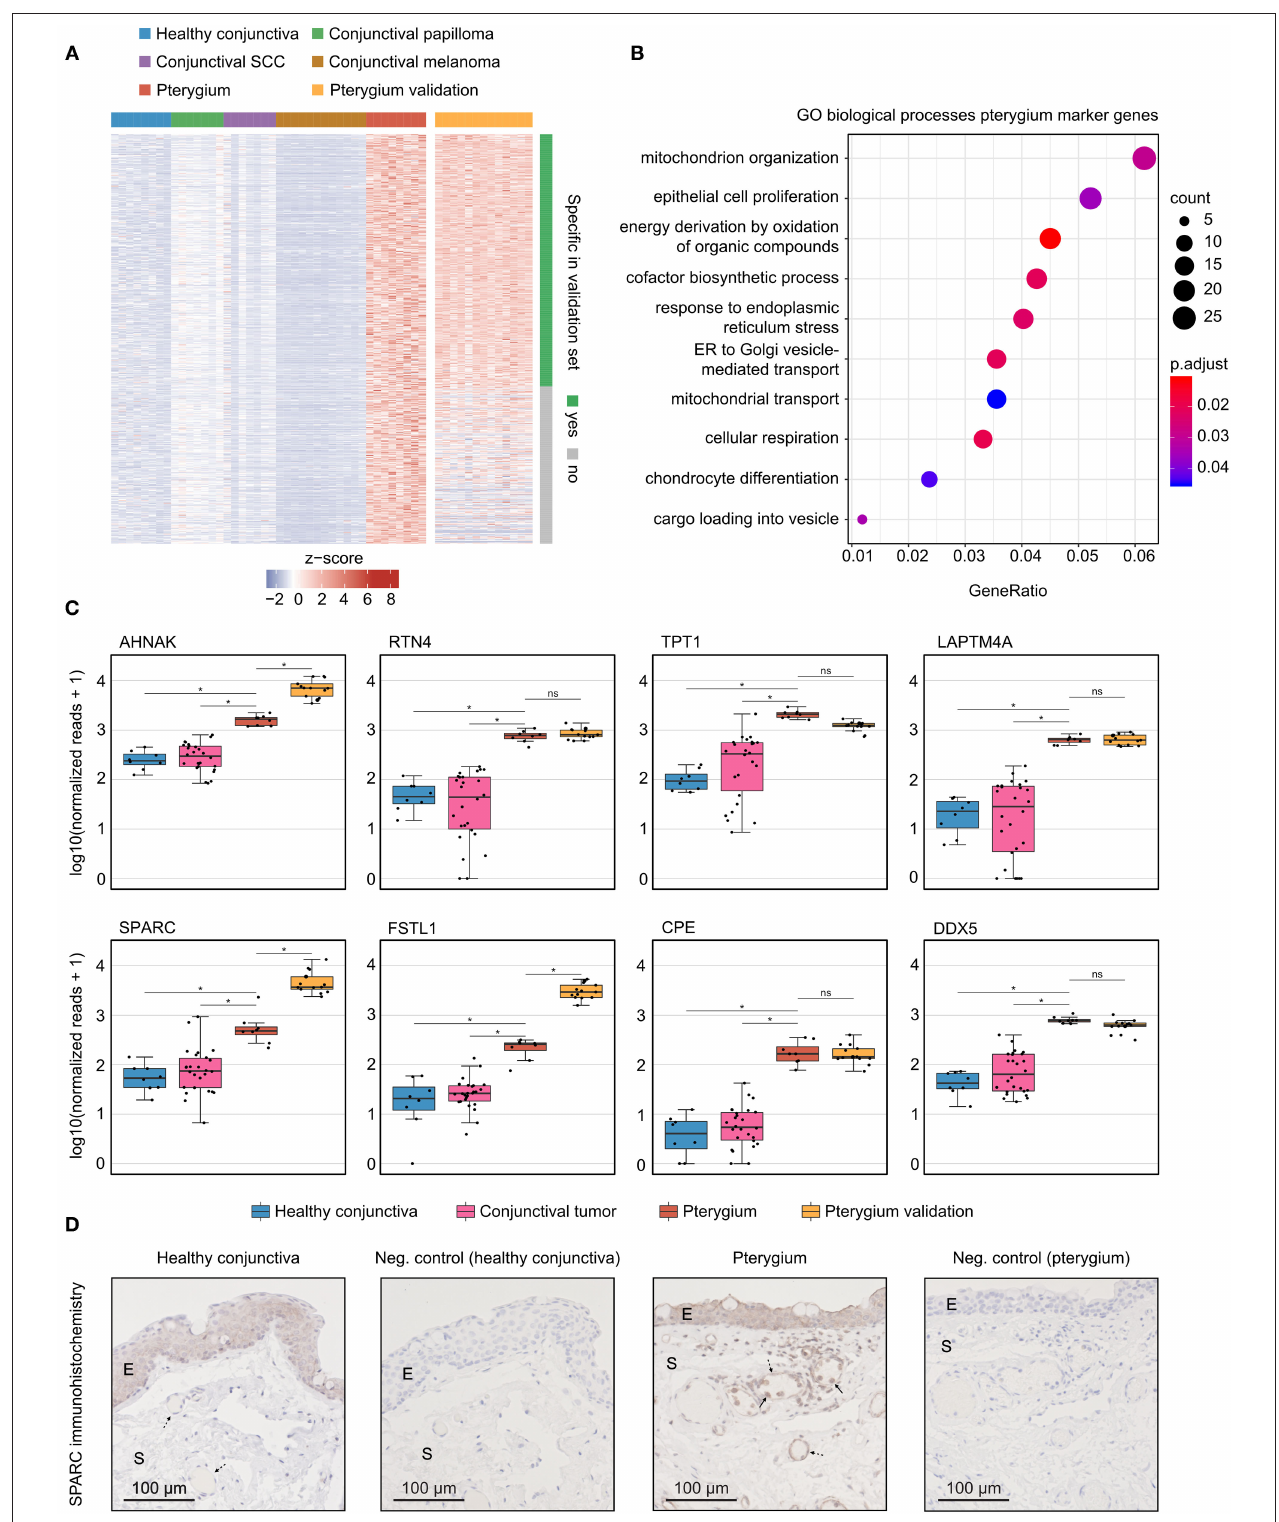
FIGURE 4 | Pterygia-specific marker genes. (A) Heatmap visualizing 731 identified marker genes in pterygia when compared to healthy conjunctiva, conjunctival papilloma, conjunctival squamous cell carcinoma and conjunctival melanoma. External validation was performed by including transcriptomic data of cultured human pterygium cells from two different studies (13, 14) (see orange columns). Each column represents one sample and each row represents one gene (see colored legend for different tissue types). Rows are ordered according to specificity in the validation datasets. Of a total of 731 identified marker genes, 450 were likewise specific